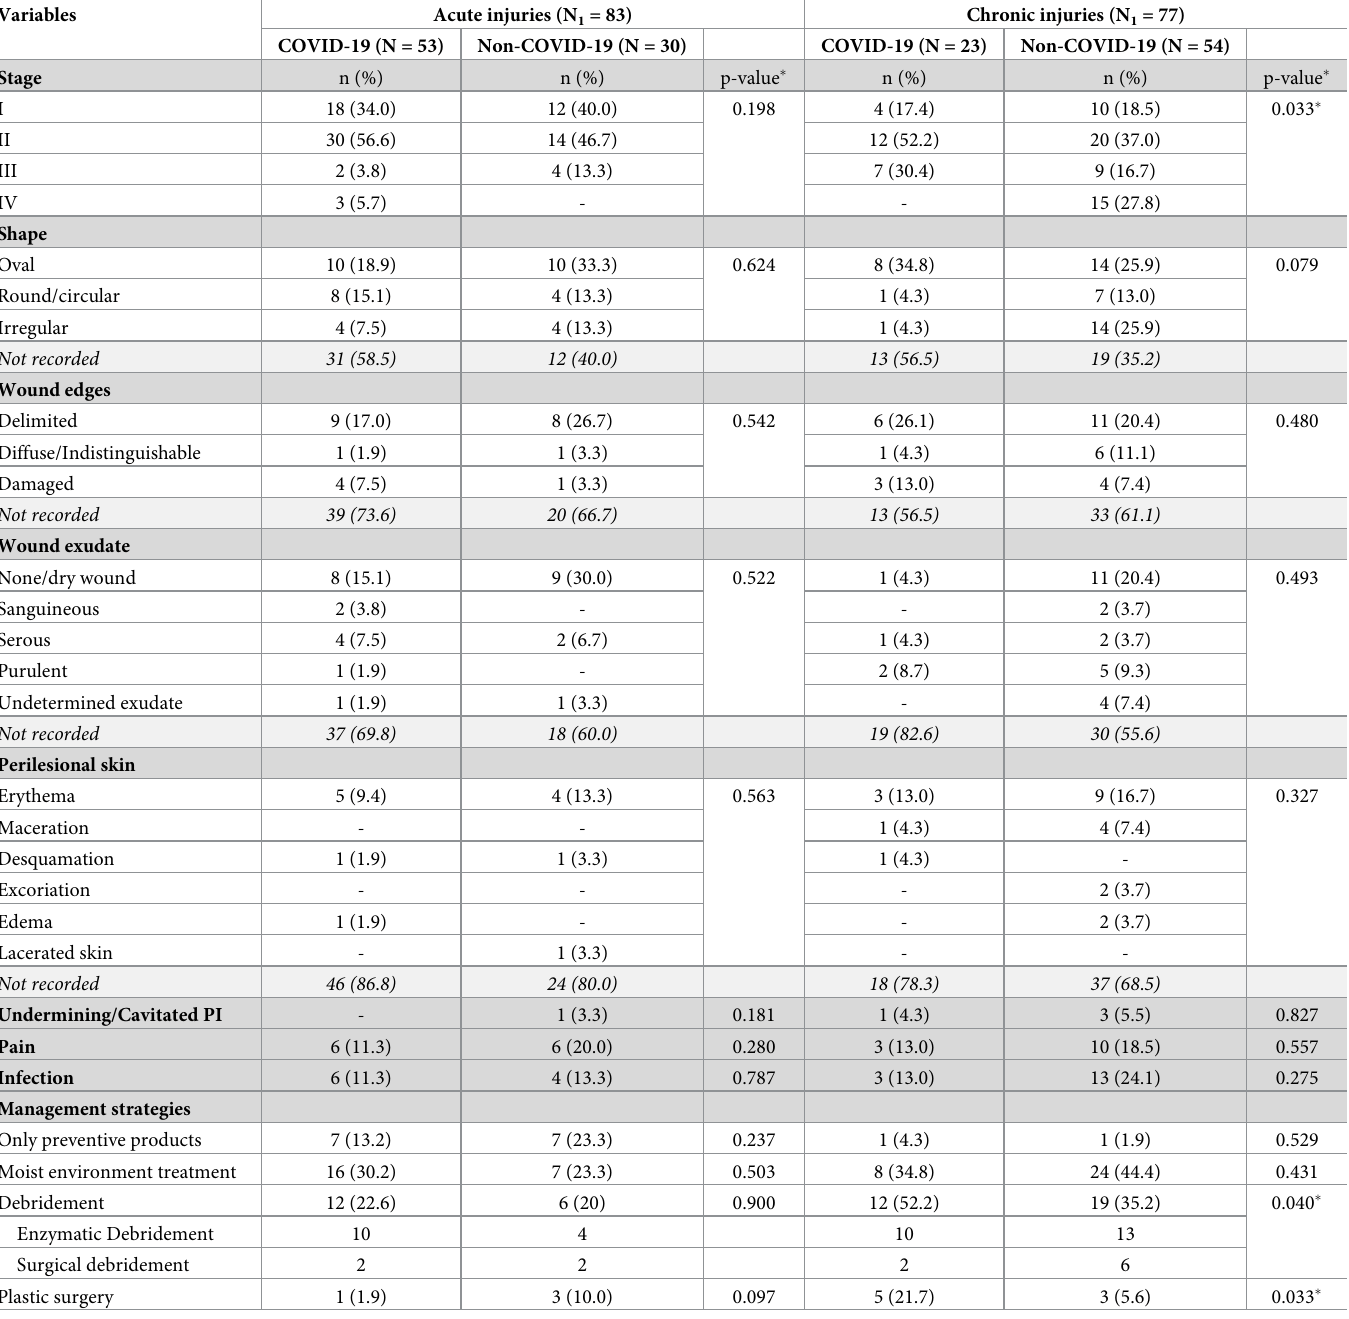
Table 2. Acute vs. chronic injuries features in COVID-19 and non-COVID-19